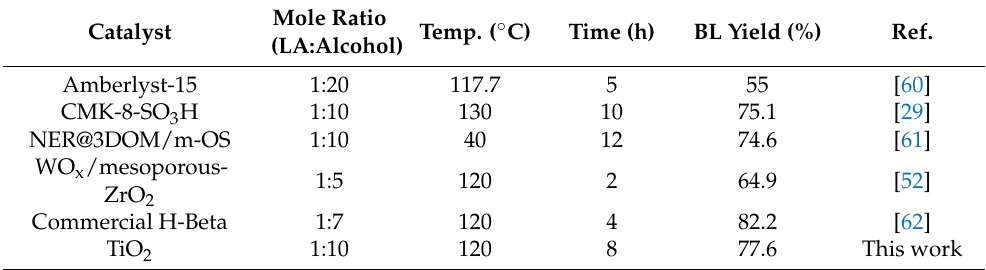
Table 4. Comparison of the catalytic performances for LA esterification using various catalysts.